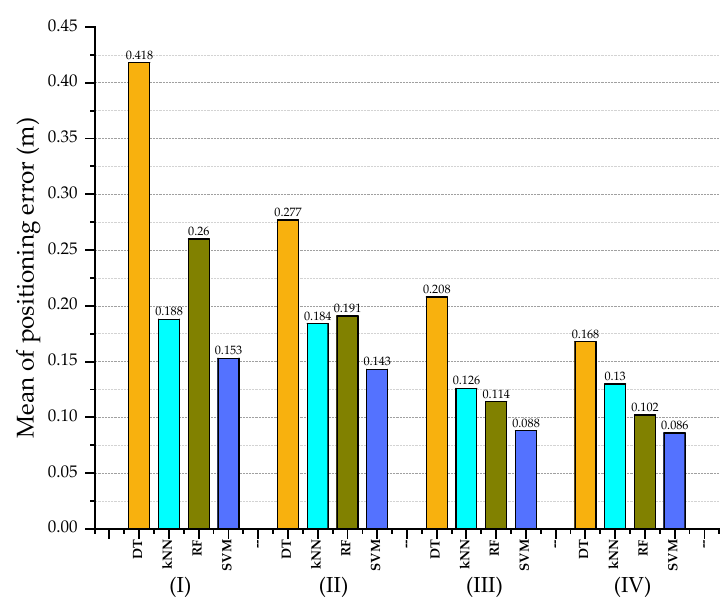
Figure 23. Detailed mean of positioning error comparison.